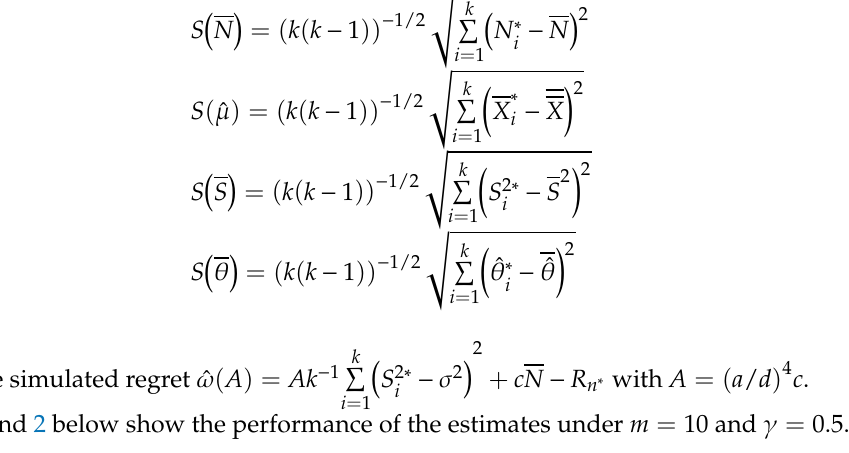
Table 1. Three-stage estimation of the mean and variance of the normal distribution under a unified